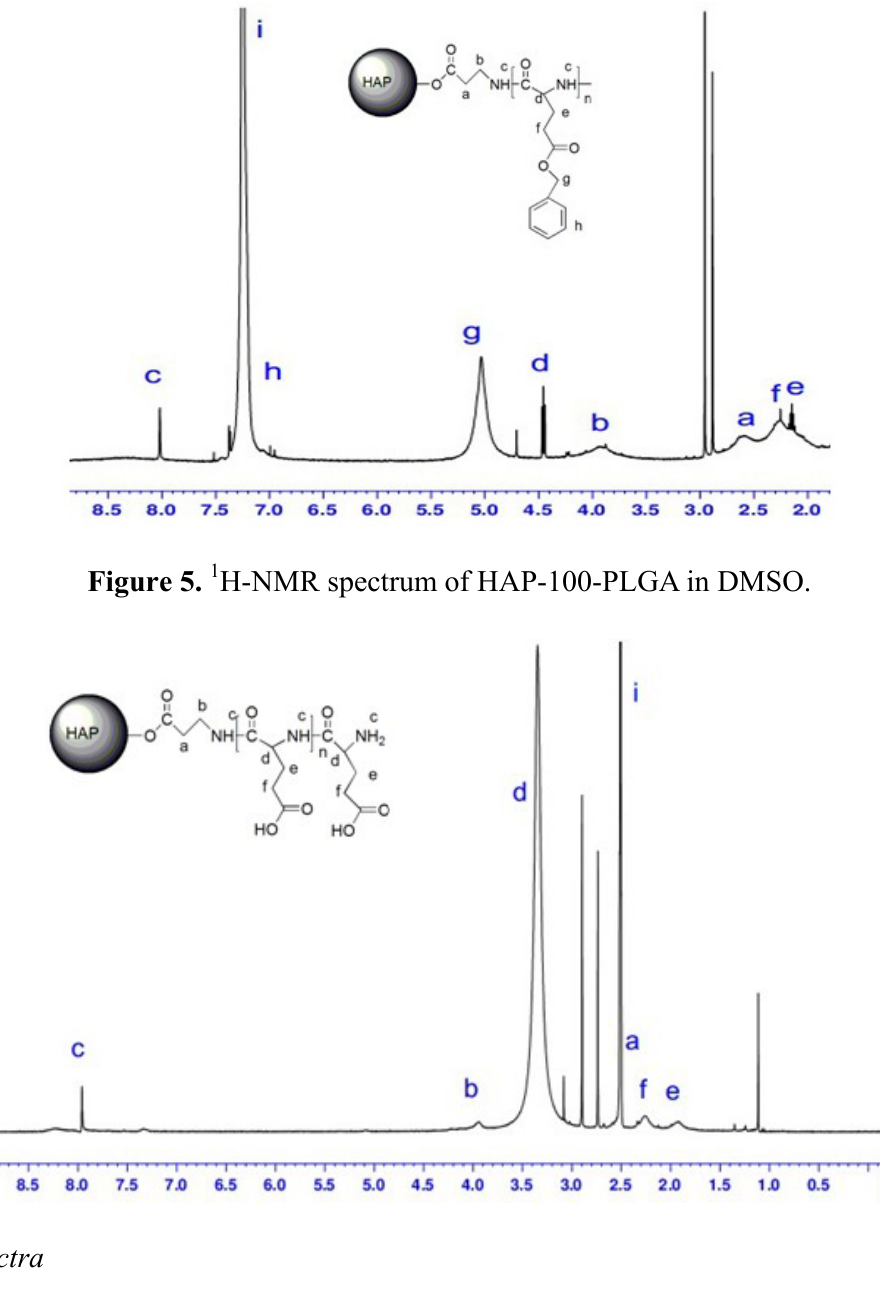
Figure 4. 1 H-NMR spectrum of HAP-100 in CDCl